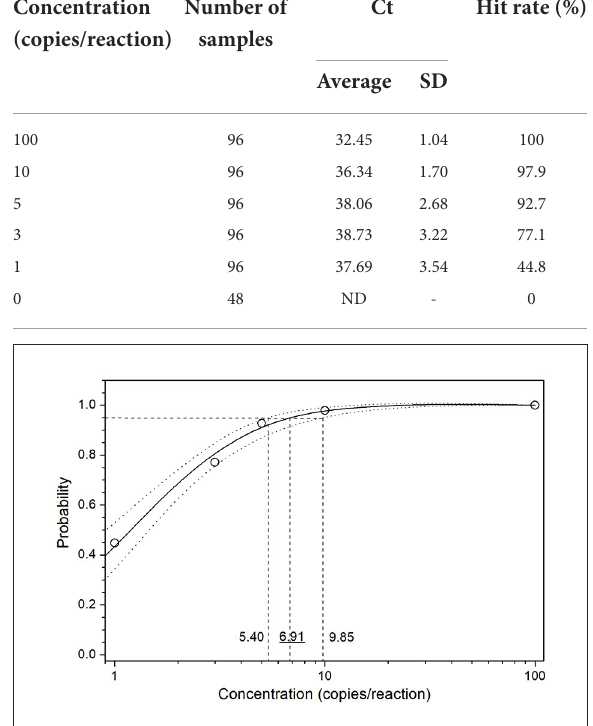
FIGURE1 PROBIT regression result for determination of the analytical sensitivity. Serial dilutions of the standard sample template GT2 were used to measure the Ct values and hit rates. The limit of detection (LoD) at 95% hit rate was determined to be